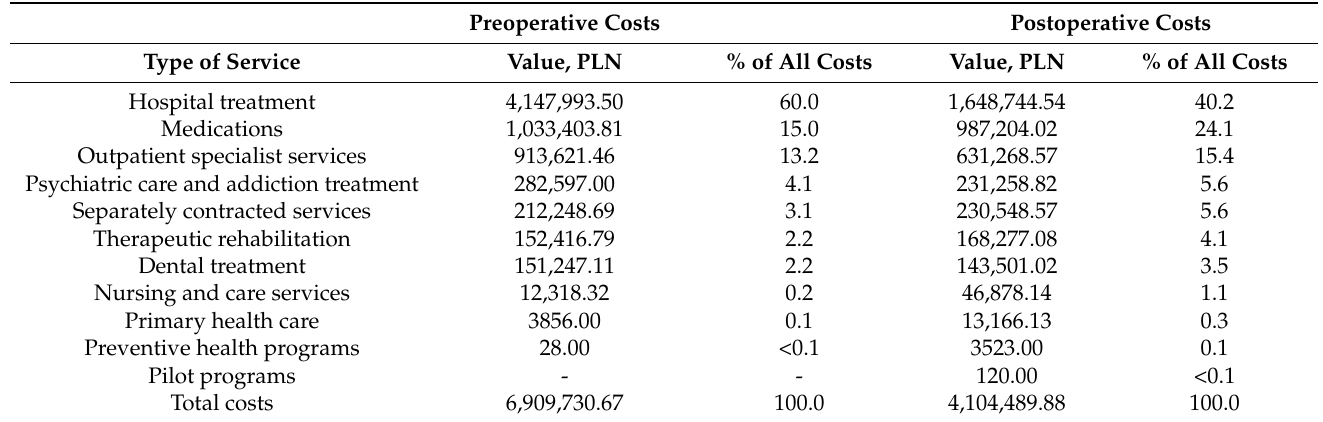
Table 2. Structure of total pre- and postoperative costs in the study group.